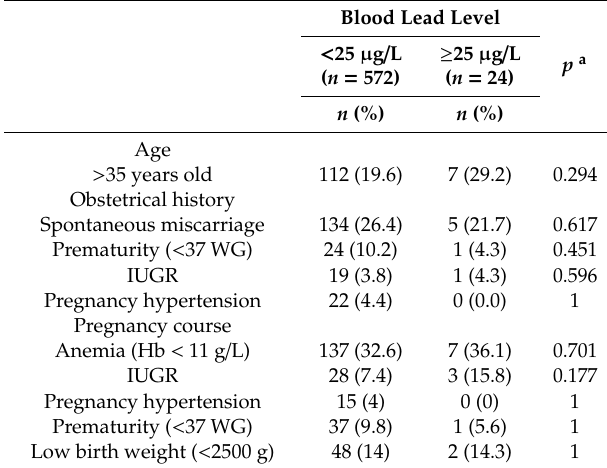
Table 4. Univariate analysis of clinical characteristics according to the level of lead impregnation ( n = 596).